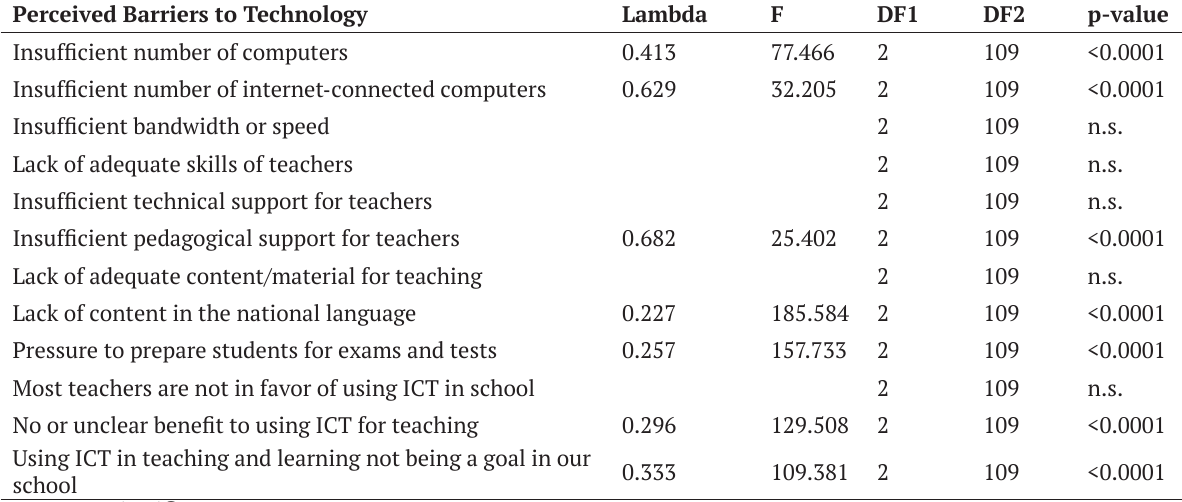
Table 3. Unidimensional test of equality of the means of the classes by Discriminant Analysis Backward (stepwise)